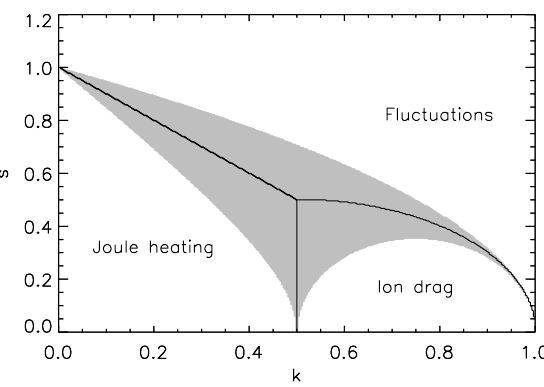
Fig. 2. Relative importance of energy sources as a function of k and s . The marked areas represent regions of parameter space in which each energy source is the most important. In the unshaded regions the marked energy source accounts for greater than 50% of the total energy